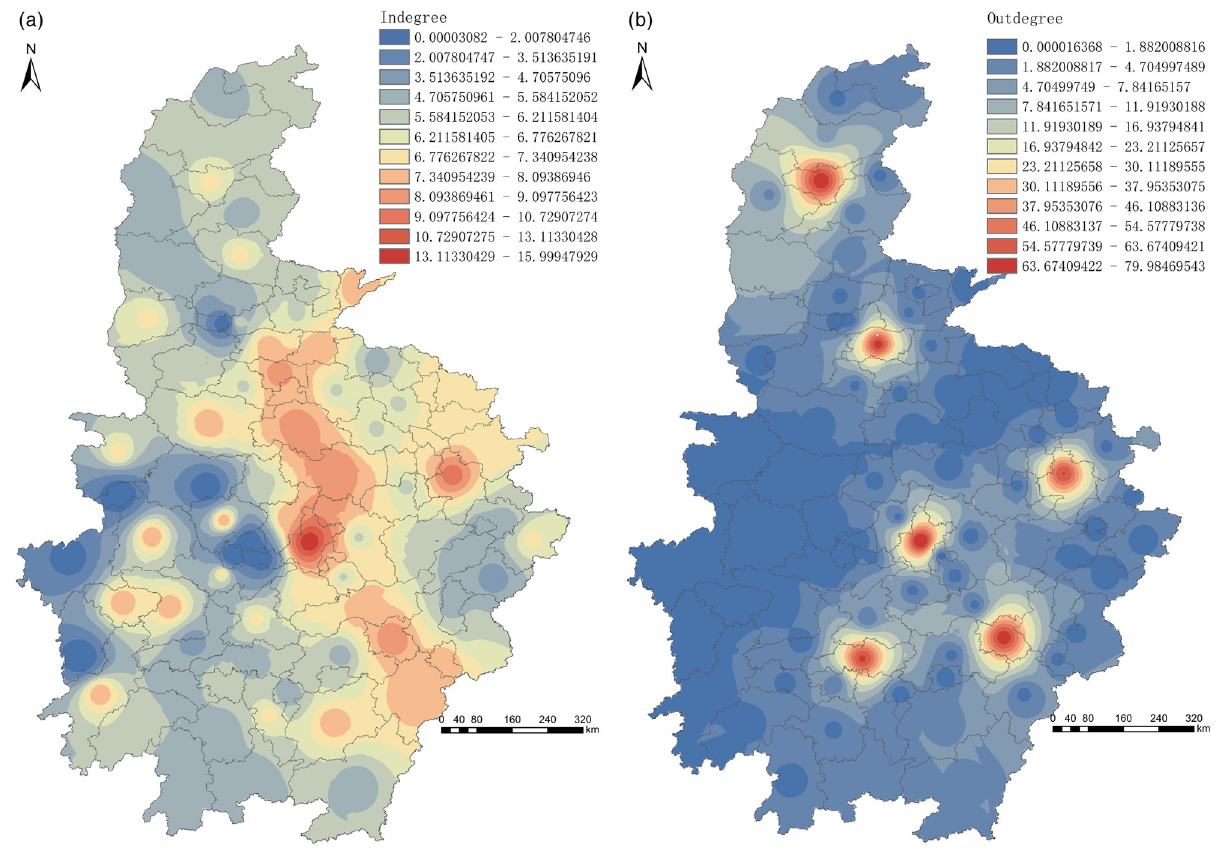
Fig 4. Spatial distribution of in-degree and out-degree in six provinces in central China. a. In-degree. b.